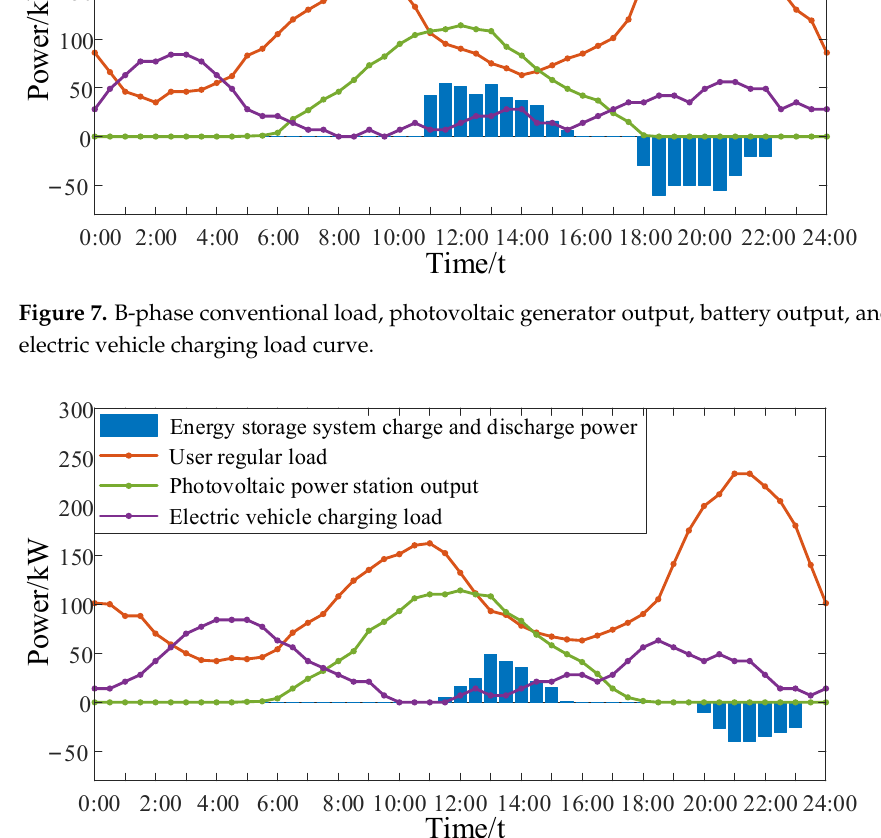
Figure 8. C-phase conventional load, photovoltaic generator output, battery output, and optimized electric vehicle charging load curve.